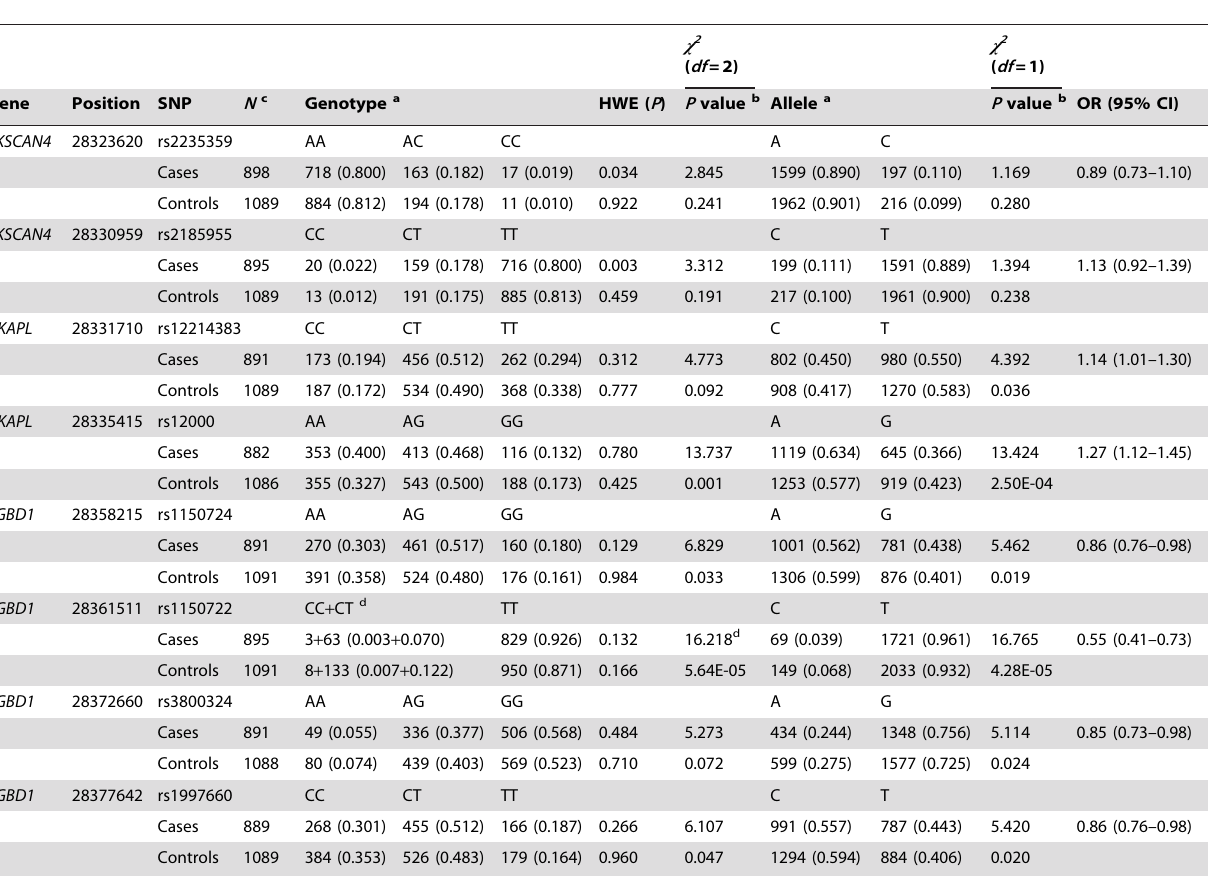
Table 1. Genotype and allele frequencies of eight SNPs and results of comparison of schizophrenia case and control groups.